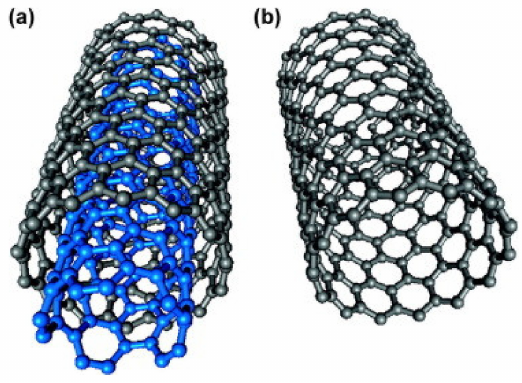
Figure 12. The structure of ( a ) MWCNT and ( b ) SWCNT